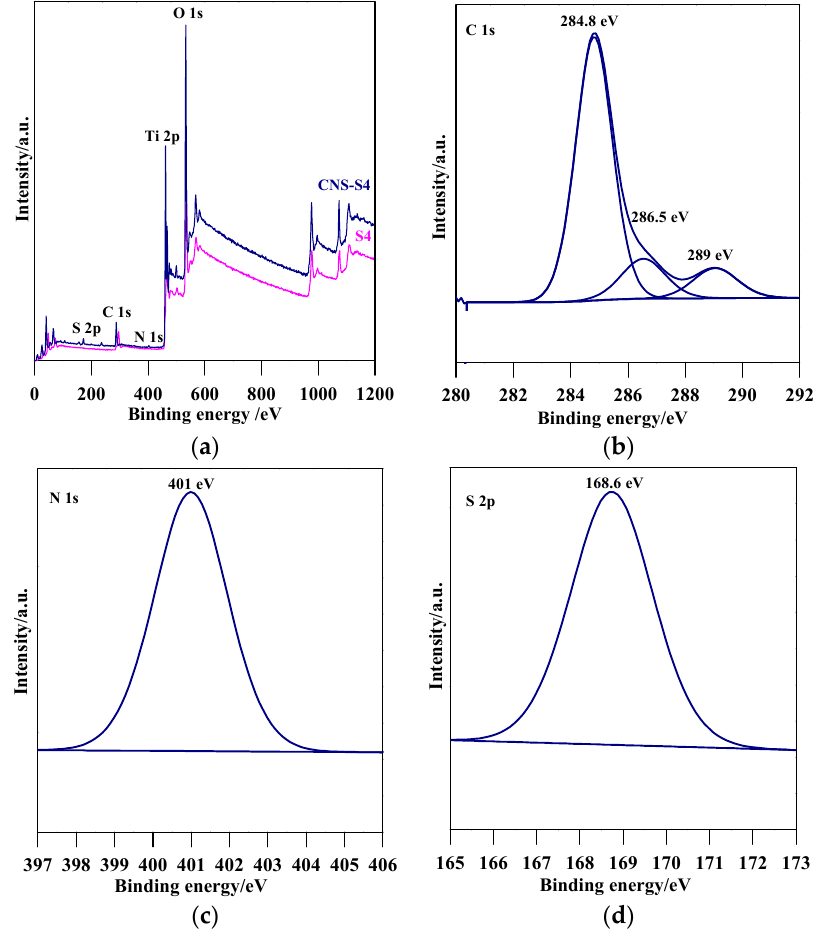
Figure 4. ( a ) XPS survey spectra for S4 and CNS-S4, and detailed scan in the energy regions of : ( b ) C 1s; ( c ) N 1s; and ( d ) S 2p of CNS-S4. 1s; ( c ) N 1s; and ( d ) S 2p of